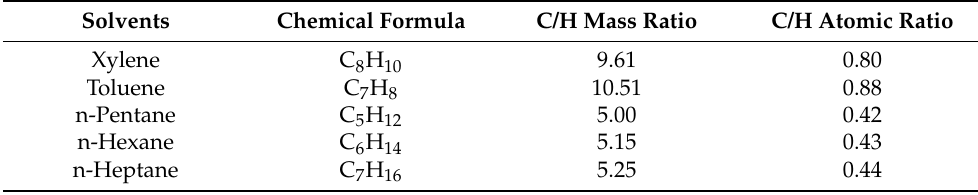
Table 4. Chemical formula, mass and atomic ratios of C/H elements for different solvents.